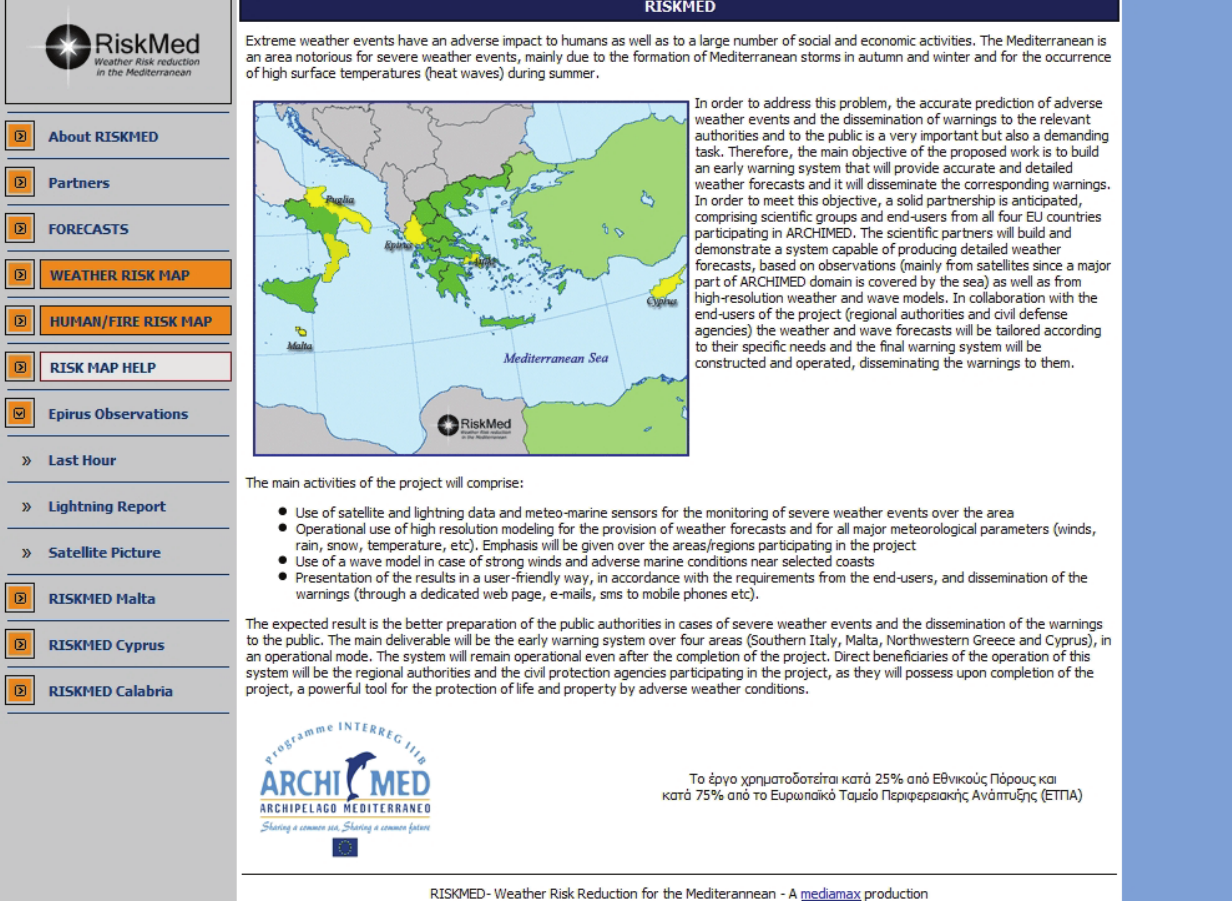
Fig. 2. The home page of the official web site of RISKMED